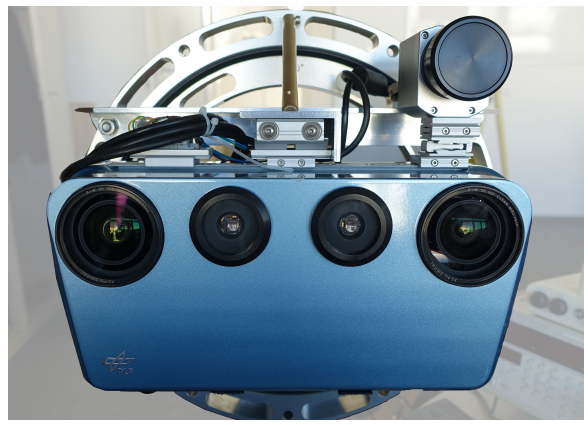
Figure 1. IPS Camera System with Optris PI 450 attached on top. The system is mounted on a rotary plate for calibration